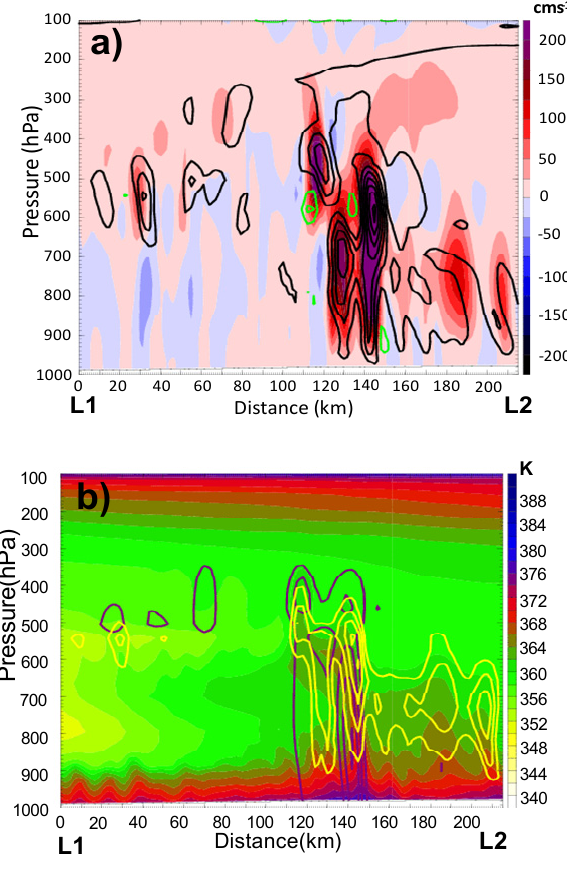
Fig. 12. (a) The cross-section distribution along L1–L2 in Fig. 10b for vertical velocity (shaded) and potential velocity (positive in black and negative in green, interval 2PVU) at 17:00UTC 7 Au- gust. (b) Same as (a) but for equivalent potential temperature (shaded), total precipitation mixing ratio (contour in pink) and total cloud mixing ratio (contour in